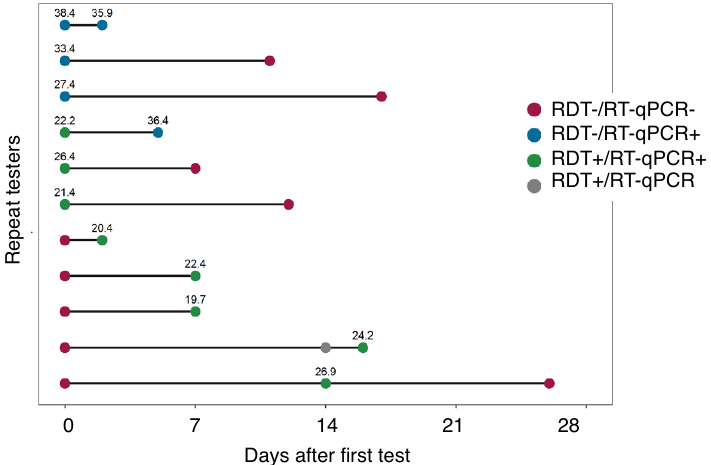
Figure 5. Individuals who enrolled in the study multiple times and had at least one positive gold standard RT-qPCR reference (n = 11). The point colors reflect the different combinations of RT-qPCR and CareStart rapid test results. The numbers above the point correspond to Ct values of the